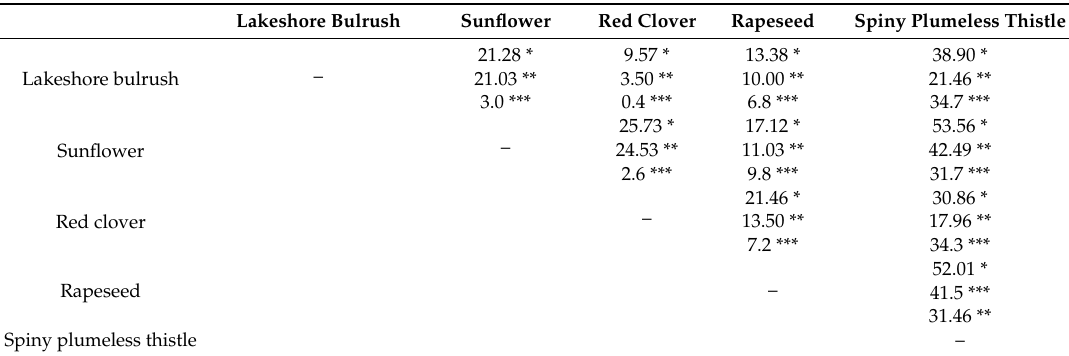
Table 3. The ∆ E* ab , ∆ C * ab and ∆ h ab values of bee pollen samples. Lakeshore